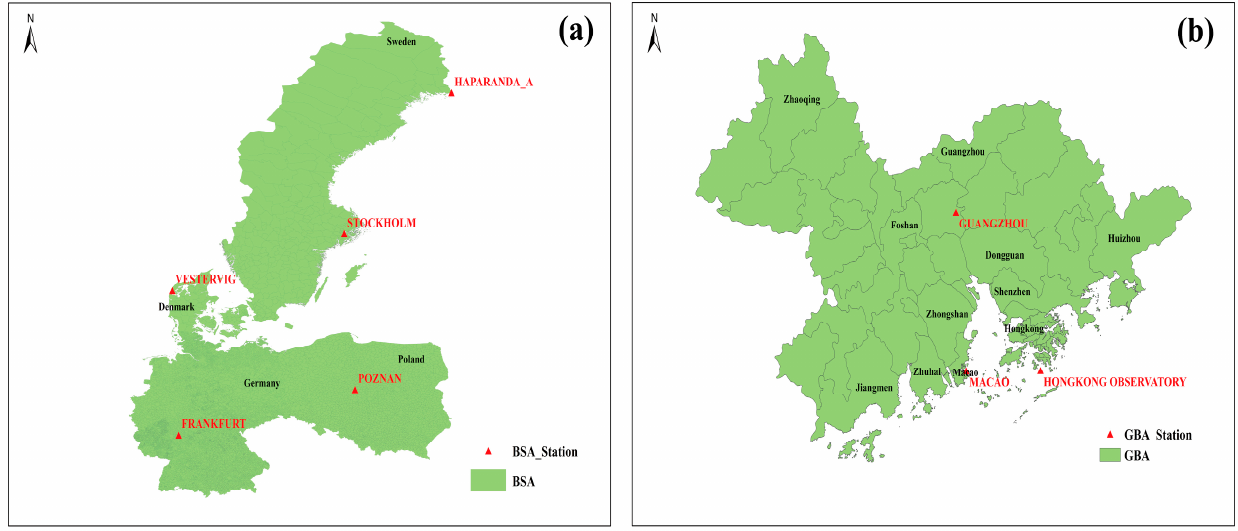
Figure 2. Representative stations in BSA area ( a ) and in GBA area ( b ). Table 1. The information of the representative stations in both areas around Baltic Sea area and the Guangdong–Hong Kong–Macao Greater Bay area.